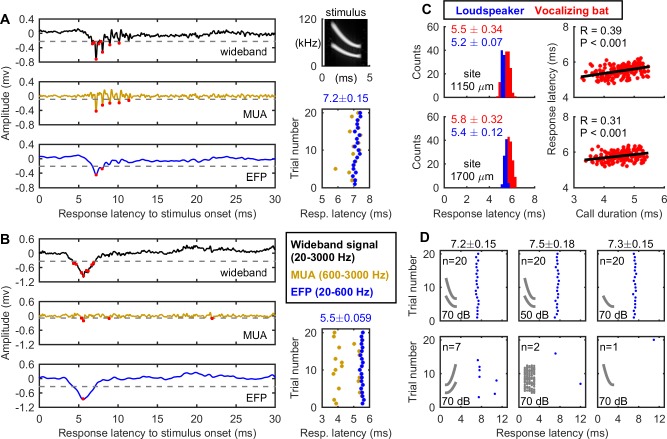
Echolocation calls evoke precise EFP in bat IC.(A, B) Two example neural recordings from a bat (R63) illustrating peaks (red dots) identified from the wideband signal (black), MUA (orange), and EFP (blue) by an adaptive threshold (gray dashed line). Both EFP and MUA were derived from the same wideband neural recording with different cutoff frequencies for the digital filters. The right column shows the spectrogram of the stimulus, the “standard” call (top), and the response latencies of the first peaks. The “standard” call was 3 ms in duration, 70-dB SPL in amplitude, and consisted of two quadratic harmonics with the first harmonic sweeping down from 55 kHz to 25 kHz. (C) Similar response latencies of EFPs were observed when the bat (R14) was either listening to simulated echolocation calls from a loudspeaker or spontaneously vocalizing bats. (D) Response latencies of EFPs were selective for stimulus parameters. Number n indicates the total number of EFP peaks detected over 20 trials, i.e., 20 repetitions of the same acoustic stimulus (gray inset). All stimuli were 3 ms in duration. The first harmonic swept down from 55 kHz to 25 kHz and the second harmonic from 110 kHz to 50 kHz. The white noise was from 110 kHz to 25 kHz. Response latency is not shown for the lower panels of (D) due to the very few responses. Data shown here were from a single bat (R63) and data from all three bats were shown in S1 Fig and S1 Data. All response latency data are presented as mean ± SD. EFP, extracellular field potential; IC, inferior colliculus; MUA, multiunit activity; SPL, sound pressure level.